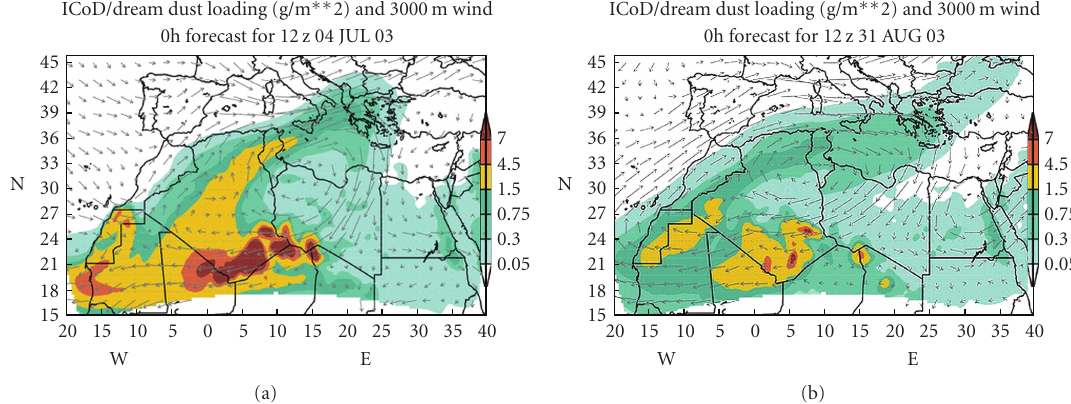
Figure 3: Dust loading (a) and dust dry deposition (b) forecasted by the DREAM model for the two dusty days (4/7/03 and 31/8/03).